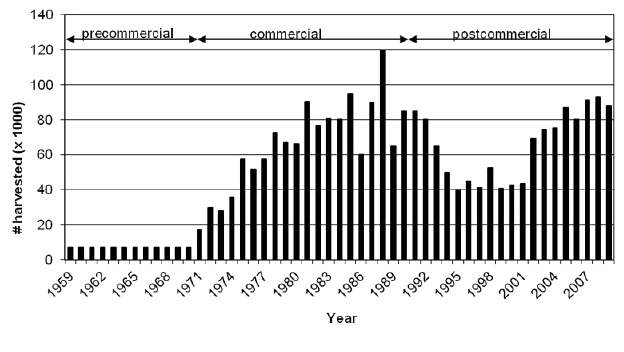
Fig. 3 . Estimated harvest of the Taimyr wild reindeer population from 1959 to present. Note: in the precommercial period the harvest was not monitored and was assumed to needs. From 1972-1995 numbers were based on formal harvest surveys. Estimates after 1995 were based on expert opinion